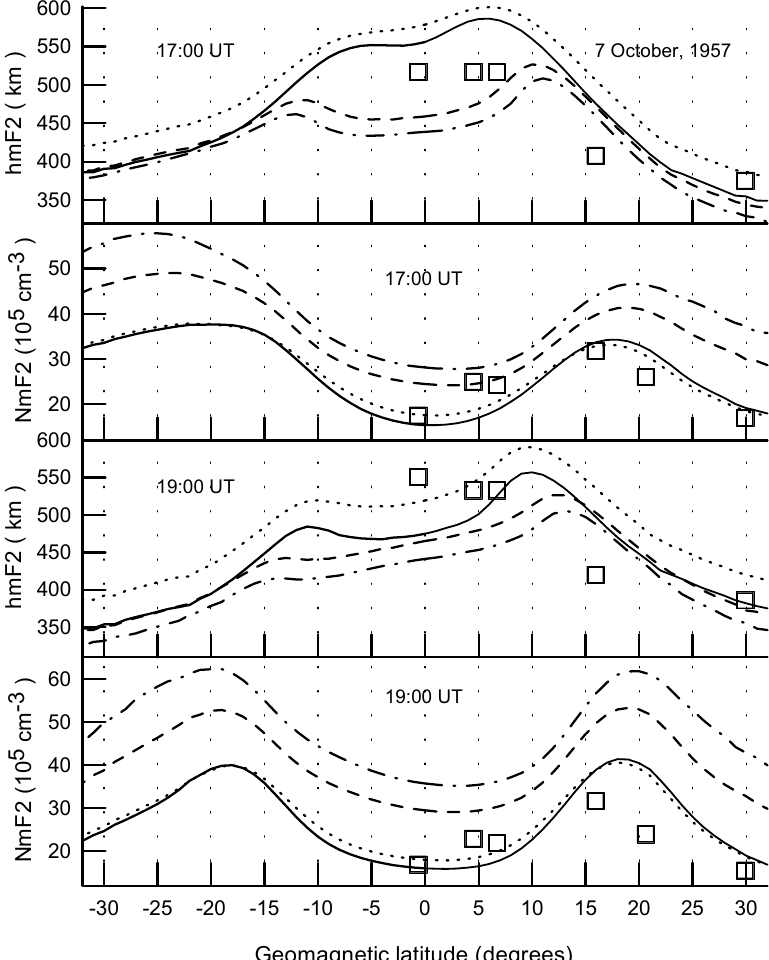
Fig. 9. Observed (squares) and calculated (lines) hm F2 and Nm F2 at 17:00 UT (two upper panels) and 19:00 UT (two lower panels) on 7 October 1957. The measured hm F2 and Nm F2 are taken from the ionospheric sounder station shown in Table 1. The results obtained from the model of the ionosphere and plasmasphere using the EUVAC solar flux model as the input model parameter. Dashed lines show the model results when the original NRLMSISE-00 neutral temperature and densities are used. Solid lines show the model results when the NRLMSISE-00 model [O] was decreased by a factor of 1.7 from 16:12 UT to 23:12 UT (from 11:00 LT to 18:00 LT, where LT is the local time at the geomagnetic equator and 351.9 ◦ of the geomagnetic longitude) during all model simulation period. Dotted lines show the model results when the NRLMSISE-00 model [N 2 ] and [O 2 ] were increased by a factor of 2.1 from 16:12 UT to 23:12 UT during all model simulation period. The vibrationally excited N 2 ( v > 0) and O 2 ( v > 0) are included in the model results shown by solid, dashed, and dotted lines. Dash-dotted lines show the model results when N 2 ( v > 0) and O 2 ( v > 0) are not included in the calculations of the O + ( 4 S) loss rate and the original NRLMSISE-00 model temperature and number densities were used. The difference between the universal time and the local time at the geomagnetic equator is